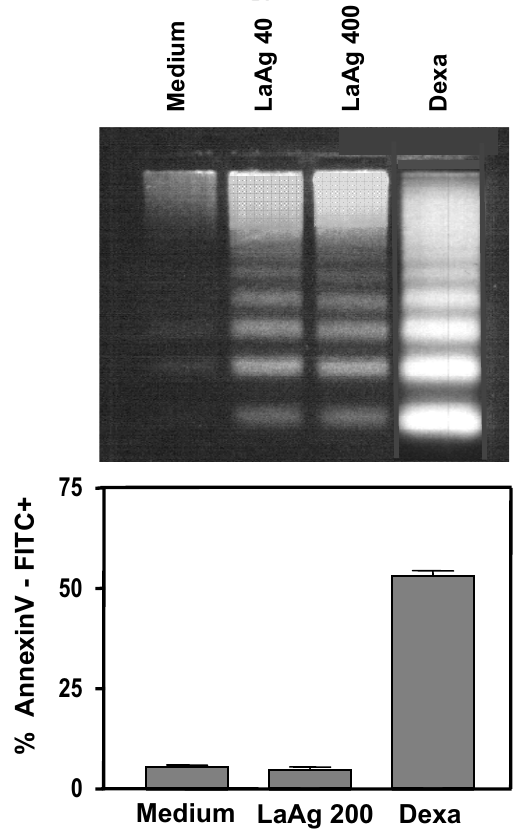
Fig. 6 – LaAg induces apoptosis in BALB/c mice infected cells. (A) Lymph node cells from L. amazonensis infected mice (day 7) were cultured for 17 hours in the presence of LaAg at 40 and